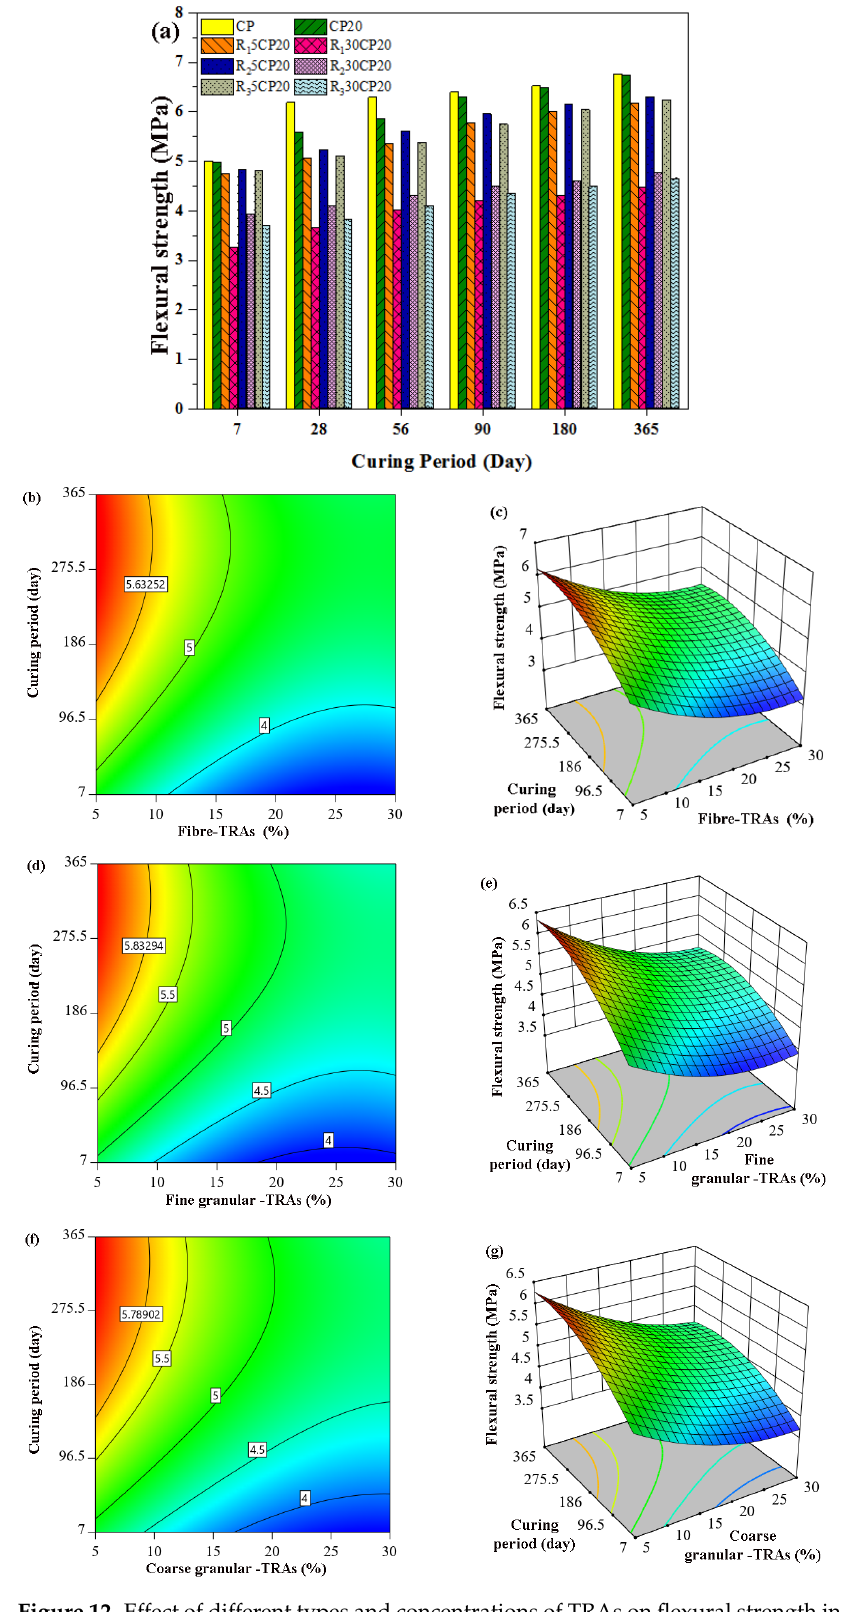
Figure 12. Effect of different types and concentrations of TRAs on flexural strength in POFA-modified concrete, ( a ) Experimental work, ( b , c ) fibre rubber, ( d , e ) fine rubber, and ( f , g ) coarse rubber.